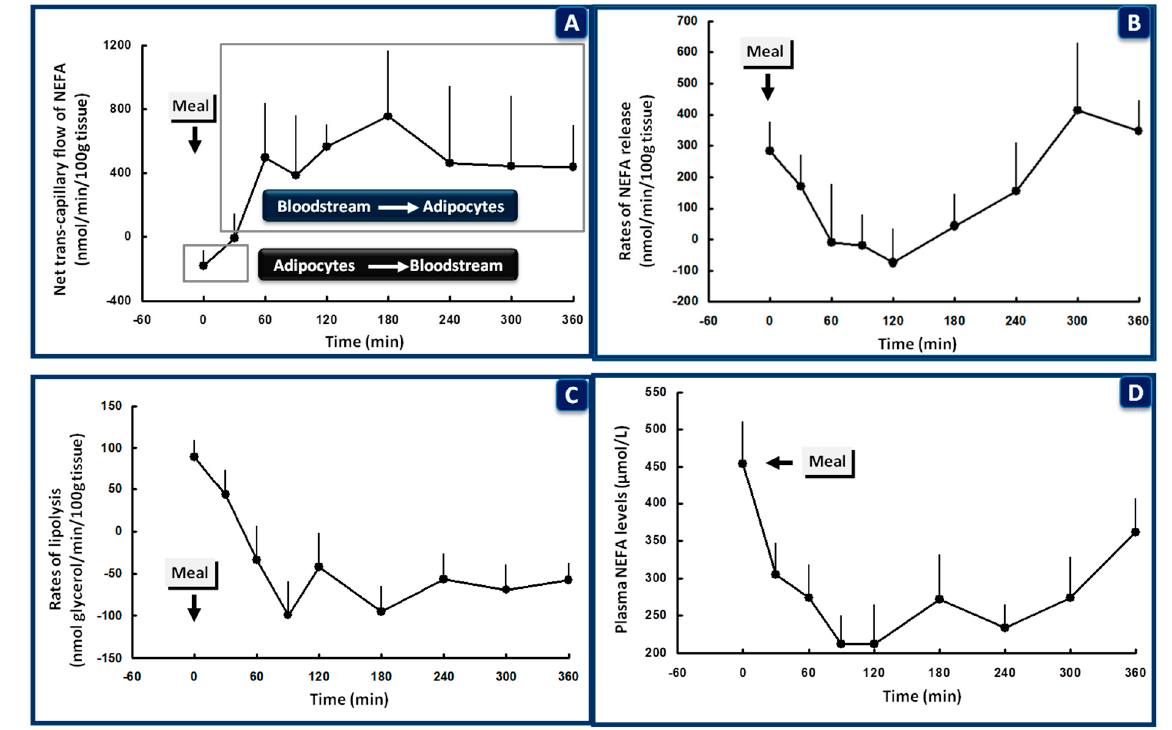
Figure 3. Nonesterified fatty acid (NEFA) kinetics in the subcutaneous adipose tissue of healthy subjects after a mixed meal given at 08:00, following overnight fasting. At the beginning of the meal (0 time), the trans-capillary flow of NEFA is from the adipocytes to the bloodstream ( A ). The rates of NEFA release ( B ), lipolysis ( C ), and plasma levels of NEFA ( D ) are all increased to cover energy requirements in muscle during sleep and sustain endogenous glucose production. Within 30 min after the beginning of the meal and in the presence of increasing blood levels of insulin, trans-capillary flow of NEFA is reversed from the bloodstream to the adipocytes ( A ). The rates of NEFA release ( B ), lipolysis ( C ), and plasma levels of NEFA ( D ) are all rapidly suppressed to allow: (a) storage of the ingested lipids in the adipose tissue; (b) suppression of endogenous glucose production by the liver and kidneys and initiation of glucose storage in the liver; (c) stimulation of glucose uptake in skeletal muscle (data from [149]).